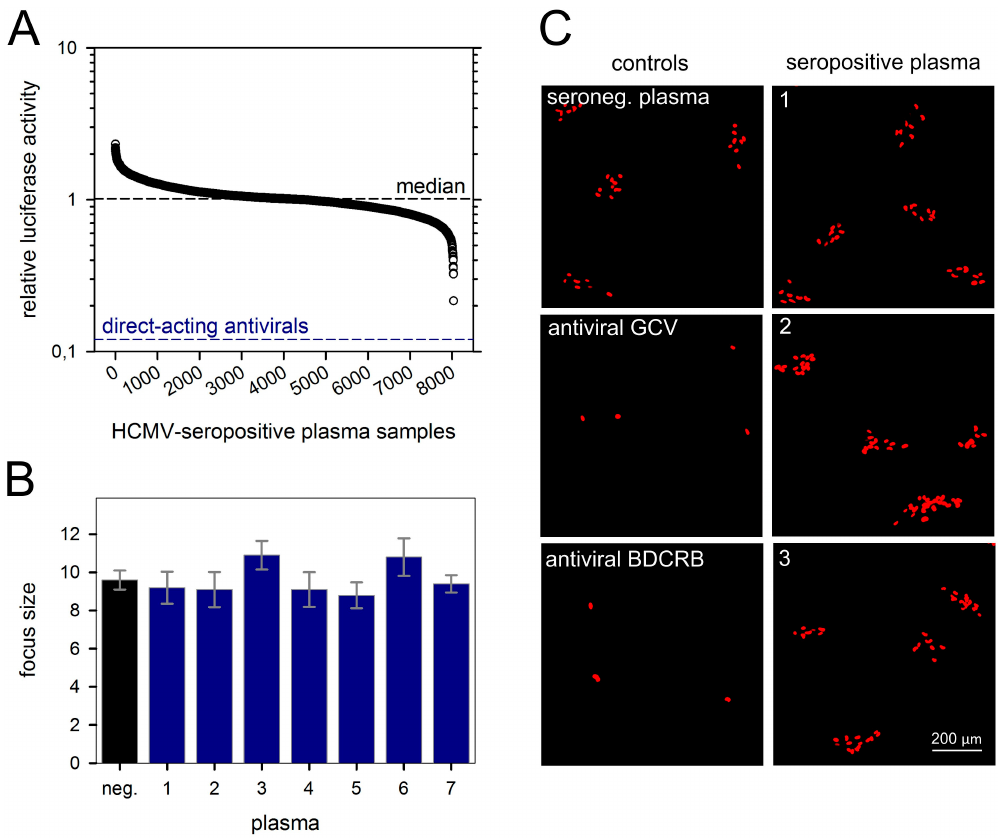
Figure 2. Plasma from HCMV-seropositive donors does not inhibit cell-associated viral spread. HFFs were seeded on microplates and infected with Merlin-pAL1502-GLuc at infection multiplicities of 0.002 FFU/cell. The day after infection (p.i.), plasma samples were added at a 50-fold dilution, and cells were incubated further. On day 5 p.i., medium was exchanged, and on day 6 p.i., supernatants were harvested for analysis of luciferase activities. Two direct-acting antivirals (GCV and BDCRB) served as positive controls for inhibition of cell-associated HCMV spread. ( A ) GLuc activities of individual plasma samples divided by the mean value of whole plate level (i.e., relative luciferase activity). Each circle represents plasma from one of 8034 HCMV-seropositive donors. The median of relative GLuc activities of all tested samples is depicted by a dashed horizontal line and represents unrestricted focal growth. The lower dashed line reflects maximal reduction of focal growth by direct-acting antivirals. ( B ) Among the 14 plasma samples that showed the highest reduction of GLuc activity, seven samples were randomly selected for a retest via immunofluorescence detection of viral IE antigens, but none of them had an effect on focal growth as compared to plasma from an HCMV-seronegative donor. Bars represent mean values of 10 foci, error bars represent the SEM. ( C ) Representative images from three of these seven retested plasmas are shown.